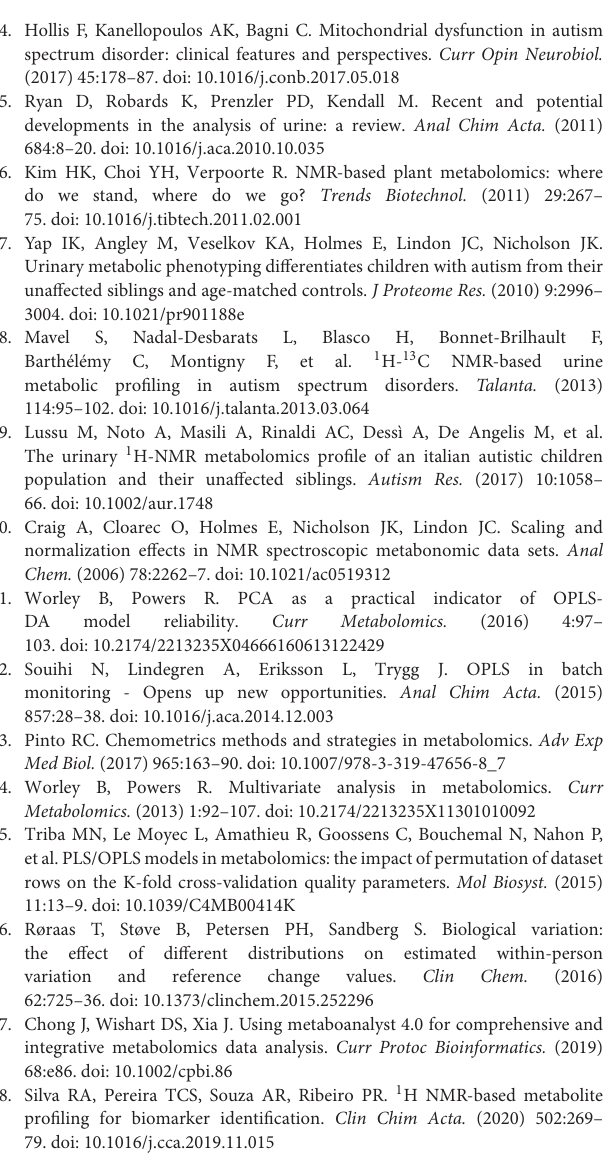
Supplementary Figure 2 | ROC curve of the metabolites. AUC, area under the ROC curve; SEN, sensitivity; SPE, specificity.